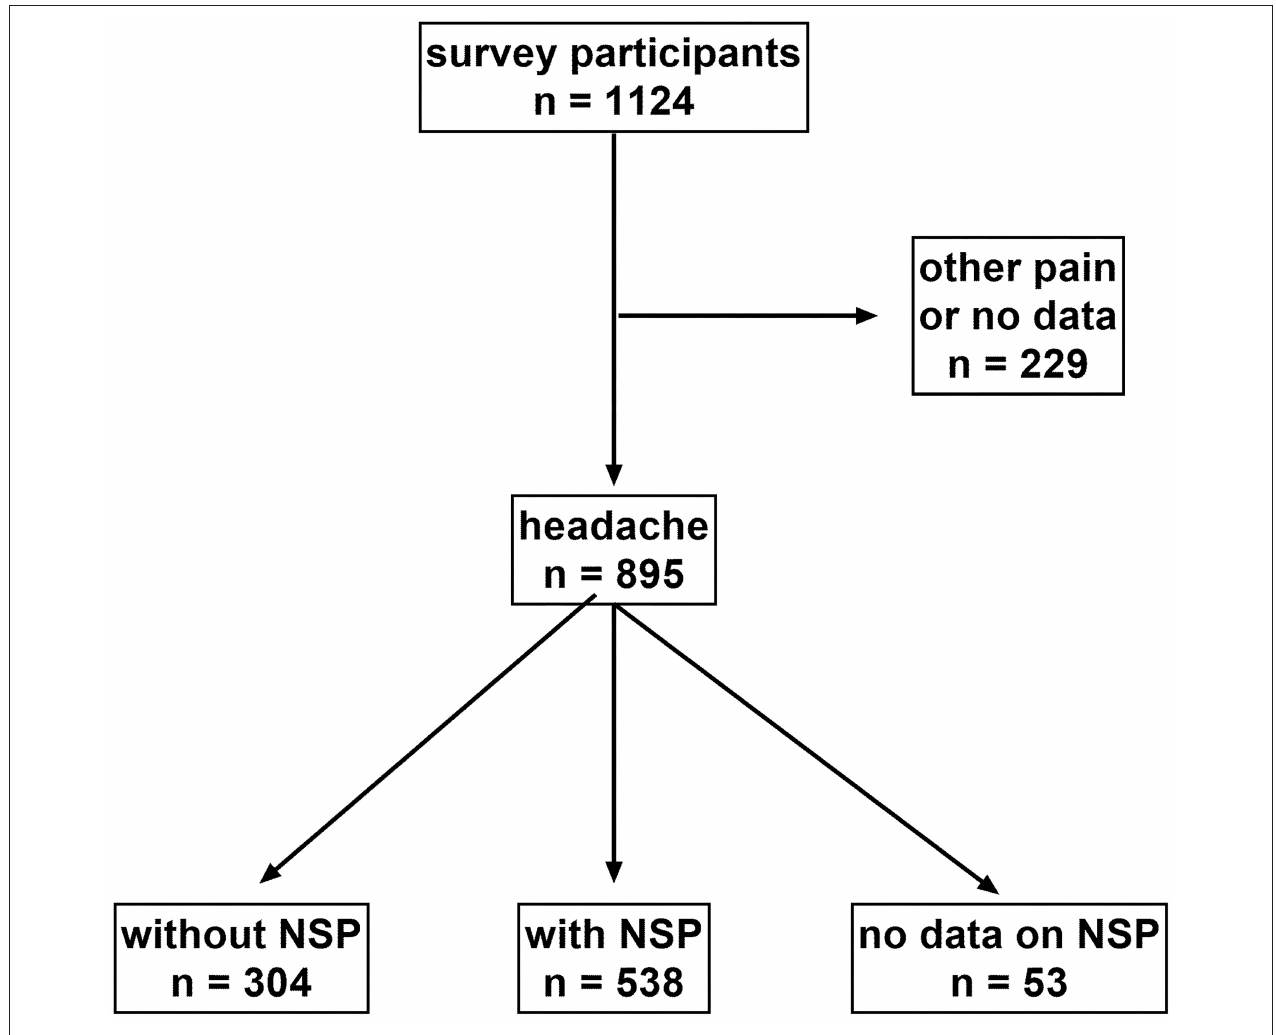
FIGURE 1 | STROBE diagram on the disposition of patients.